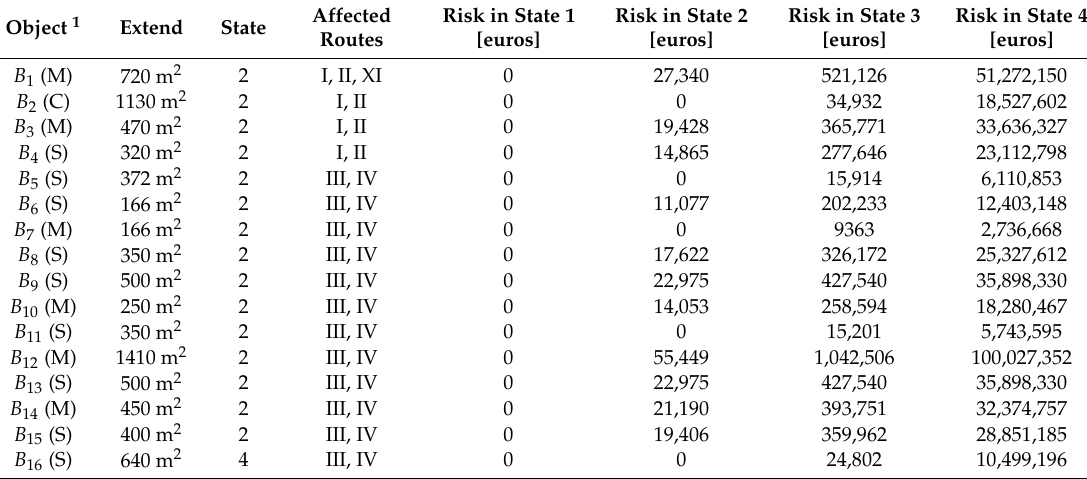
Table A2. Bridge objects (part